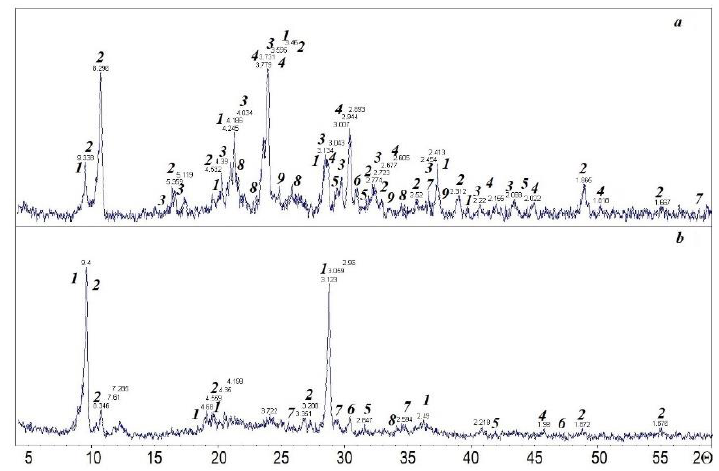
Figure 4. XRD pattern of the clinker after roasting at 400 °C ( a ) and of the leaching residue ( b ). Numbers indicate reflexes: 1—talc; 2—coquimbite; 3—mohrite; 4—cristobalite; 5—pyrrhotite; 6—pentlandite; 7—magnetite; 8—nickel sulfate; 9—chalcocyanite.